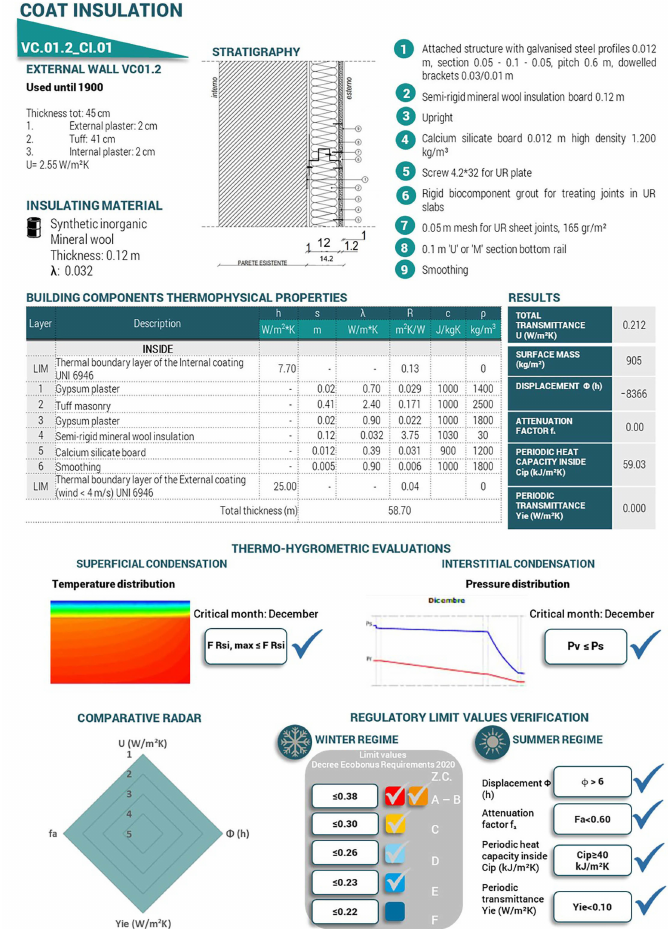
Figure 8. Performance sheet of the thermal insulating solution CI.01 applied to the existing perimeter wall